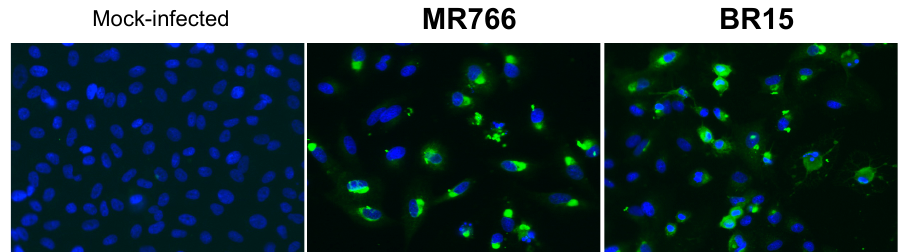
Figure 7. Reactivity of anti-rNS1 immune serum against ZIKV NS1 synthesized in human cells. A549 cells were infected 48 h with ZIKV strains MR766 and BR15 or mock-infected and analyzed by IF assay. Fixed cells were permeabilized with non-ionic detergent and then incubated with rat anti-rNS1 immune serum at dilution 1:2000. Magnification: ×400.